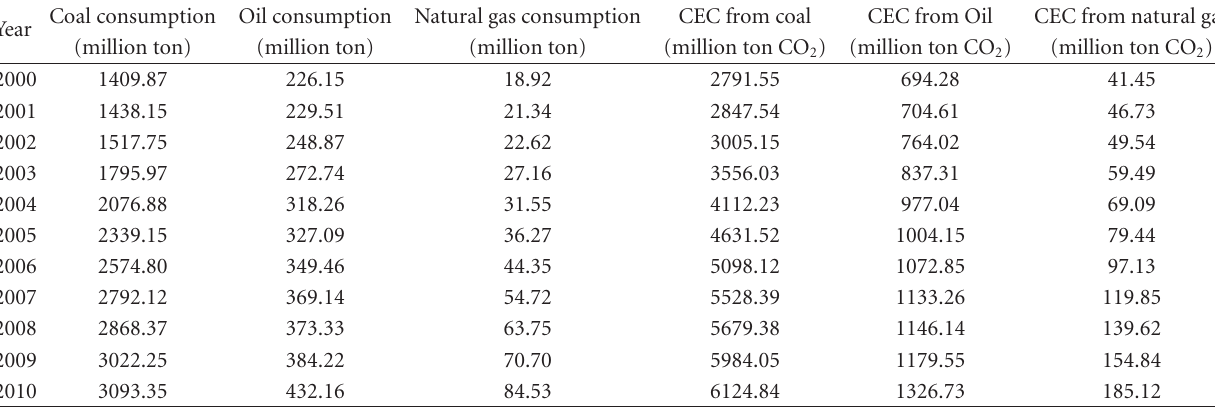
Table 6: CEC from di ff erent types of the fossil fuel consumption from 2000 to 2010 in